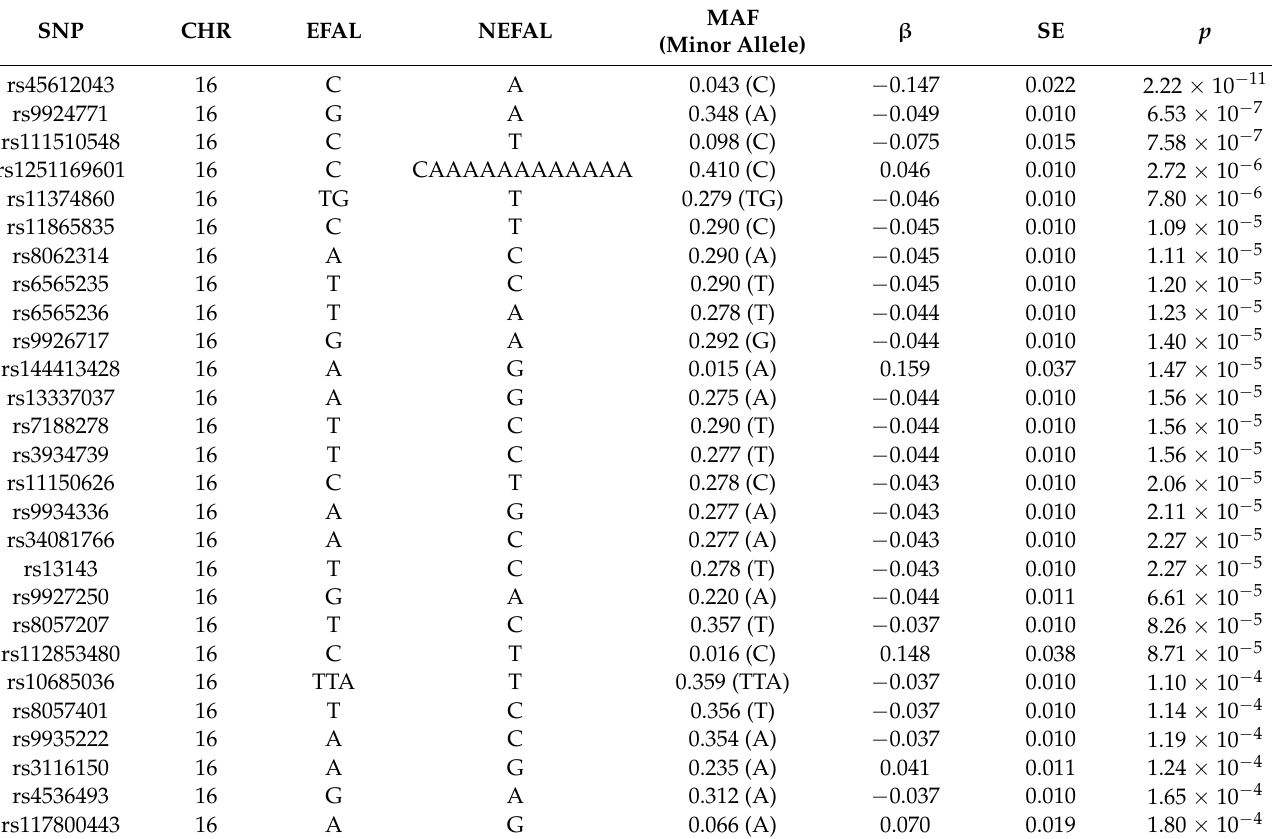
Figure 3. The association of SNPs within 25 kb of the SLC5A2 gene with HbA1c. Regional plots for HbA1c-associated SNPs located in the SLC5A2 gene or within 25 kb of the 5′ and 3′ flanking regions in the UK Biobank. Linkage disequilibrium (r 2 ) is shown between rs45612043 (purple diamond) and the other SNPs in this plot. Unknown linkage disequilibrium estimates are shown in gray color. Table 2. SNPs Significantly Associated with HbA1c in UK Biobank.